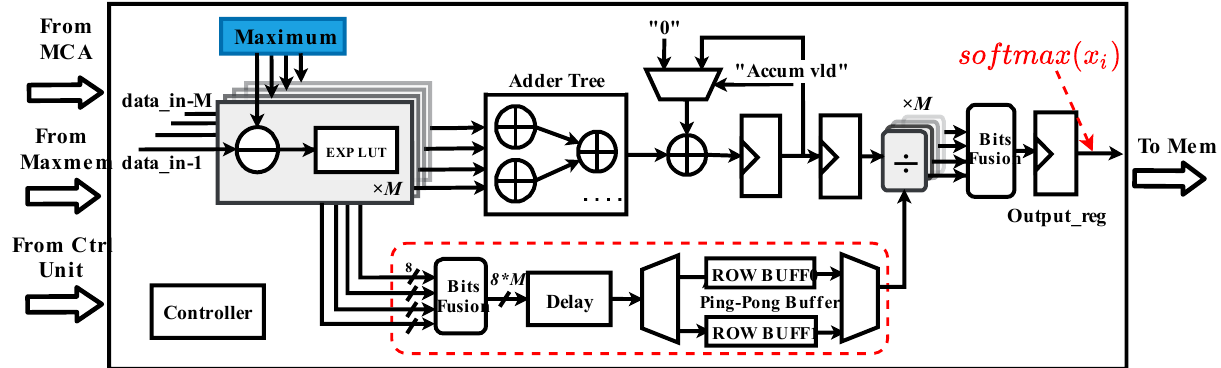
Figure 4. The detailed architecture of SMC.